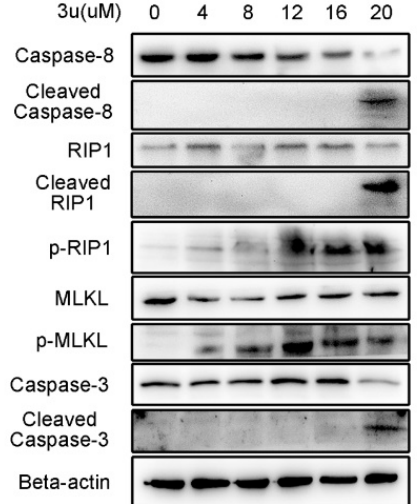
Figure 7. Caspase inhibitor zVAD-fmk promoted necroptosis at high concentrations of 3u while inhibiting apoptosis. Apoptosis- and necroptosis-related proteins were examined using Western blot analysis after a 30 µM zVAD-fmk pretreatment for 1 h and treatment with various concentrations of 3u for 6 h in A375 cells.